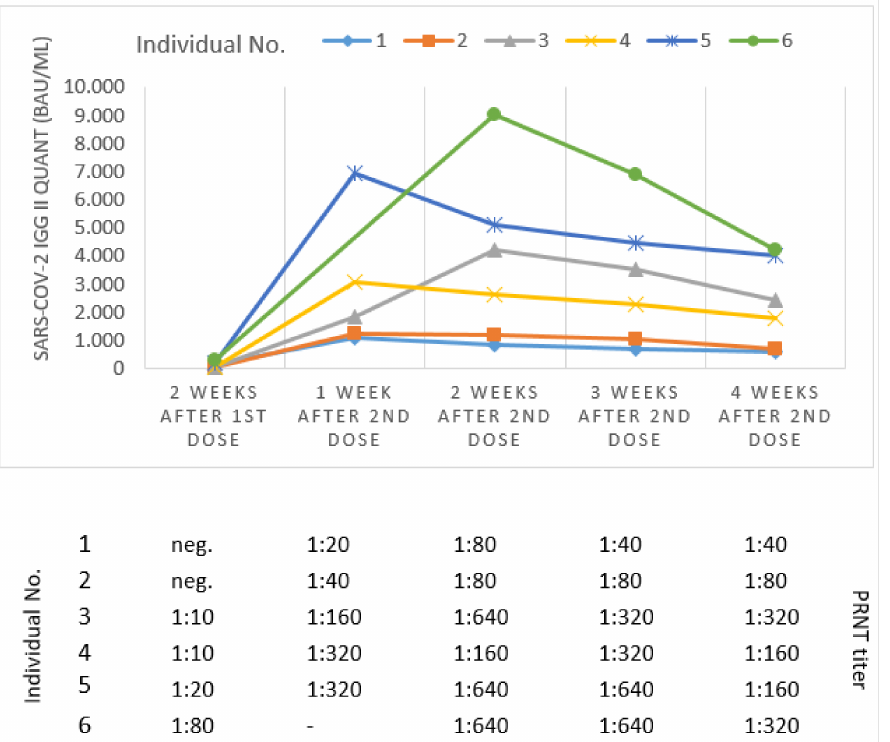
Figure 1. SARS-CoV-2 (RBD) IgG and PRNT antibody titers in follow-up serum samples of six individuals vaccinated with BNT162b2. neg. = negative; - not